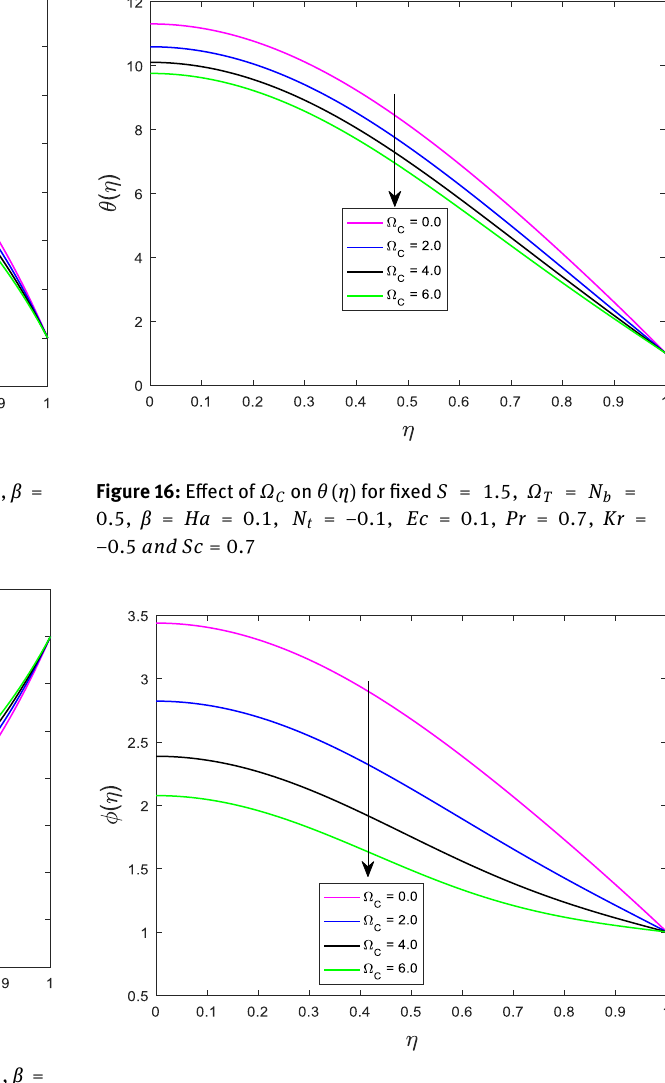
Figure 17: Effect of Ω C on ϕ ( η ) for fixed S = 1.5, Ω T = N b = 0.5, β = Ha = 0.1, N = −0.1, Ec = 0.1, Pr = 0.7, Kr = t −0.5 and Sc =